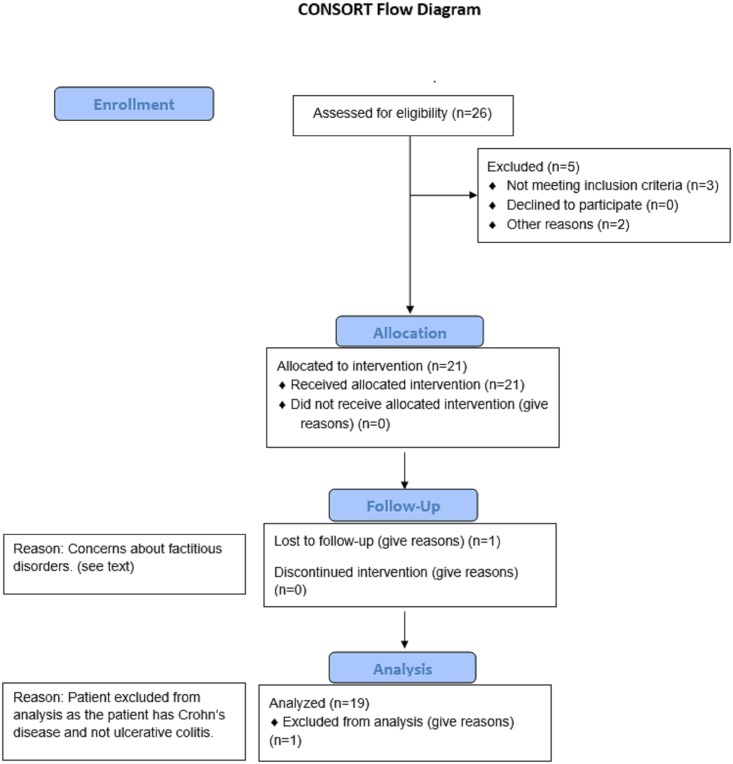
CONSORT flow diagram.